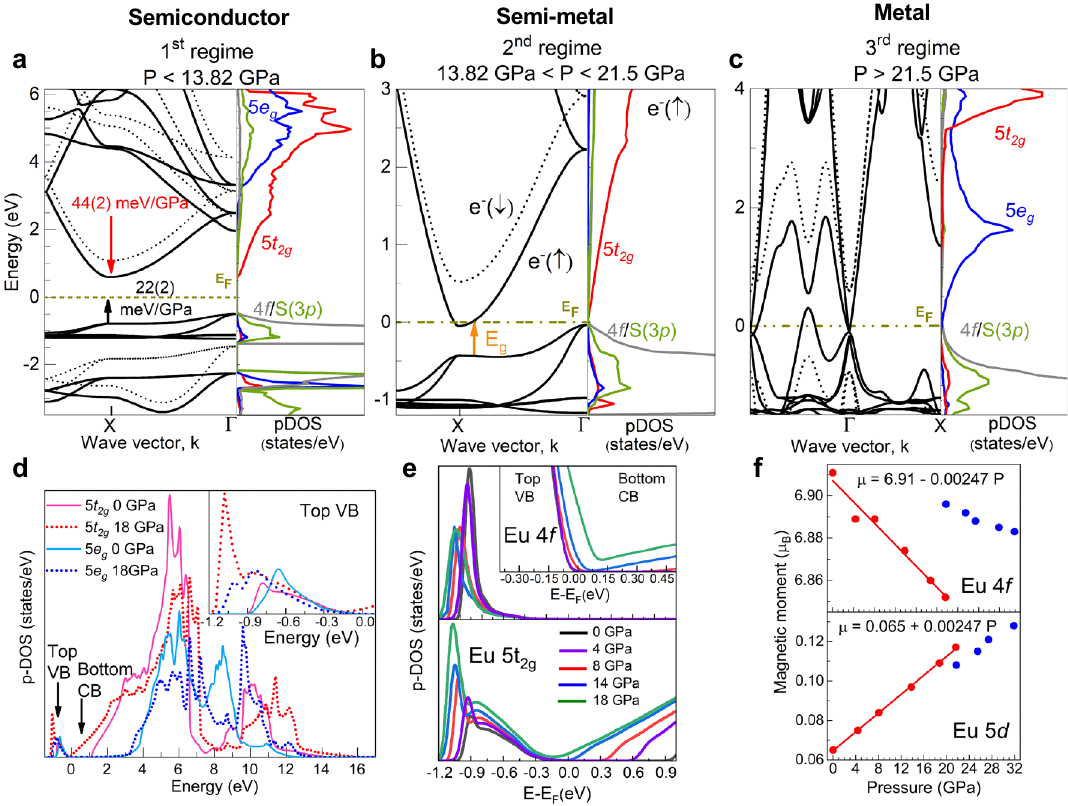
Figure 5. ( a ) Band structure and p-DOS of EuS, around E F , at 0 GPa in the semiconductor phase, ( b ) at 13.8 GPa in the half-metal phase and ( c ) at 21.5 GPa in the metal phase. Solid and dashed lines correspond to spin-up and spin down states, respectively. The onset of the half-metal phase ( b ) is characterized by the closure of the indirect gap Ŵ → X , the transition to the metallic phase ( c ) by the gap closure at Ŵ . Note the inversion of the energetic position of the t 2 g and the e g band during the half-metal to metal phase transition which is also evident in ( d ) showing the p-DOS of the Eu 5 t 2 g and 5 e g orbitals in the range between − 1.2 and 16 eV. ( e ) p-DOS of the Eu 4 f and 5 t 2 g states in the pressure range between 0 and 18 GPa. The inset shows a detail of the Eu 4 f DOS. At 18 GPa the Eu 5 t 2 g level has a finite DOS at E F indicating the onset of metallization. ( f ) Orbital- resolved magnetic moment of 4 f and 5 d levels versus the shortening of the Eu-S bond length with pressure. Overall, this leads to a pressure-induced gradient of the theoretical energy gap, E GAP , of − 70(2) meV GPa − 1 , being consistent with the experimental result (− 89(3) meV